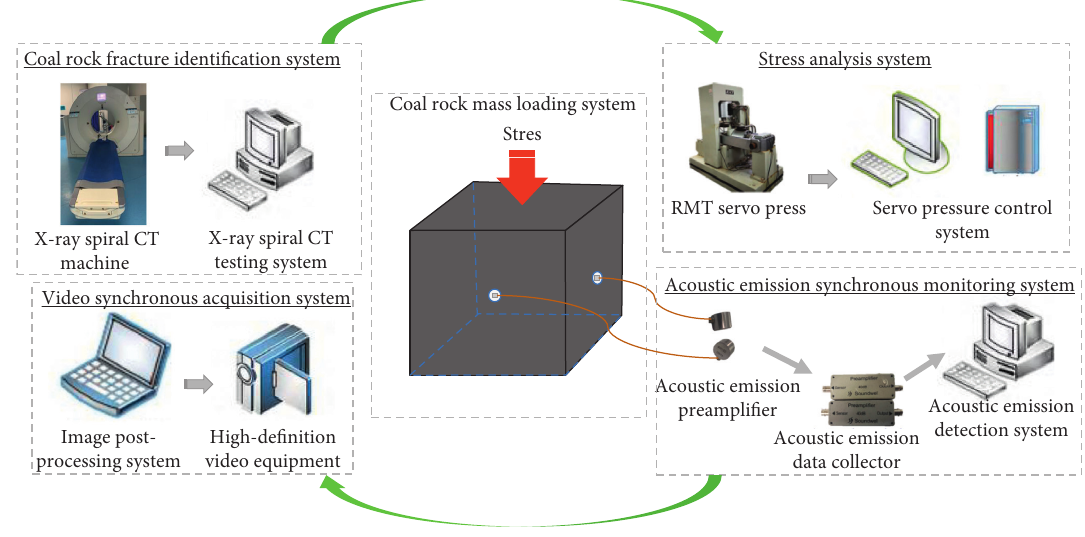
Figure 2: Experiment